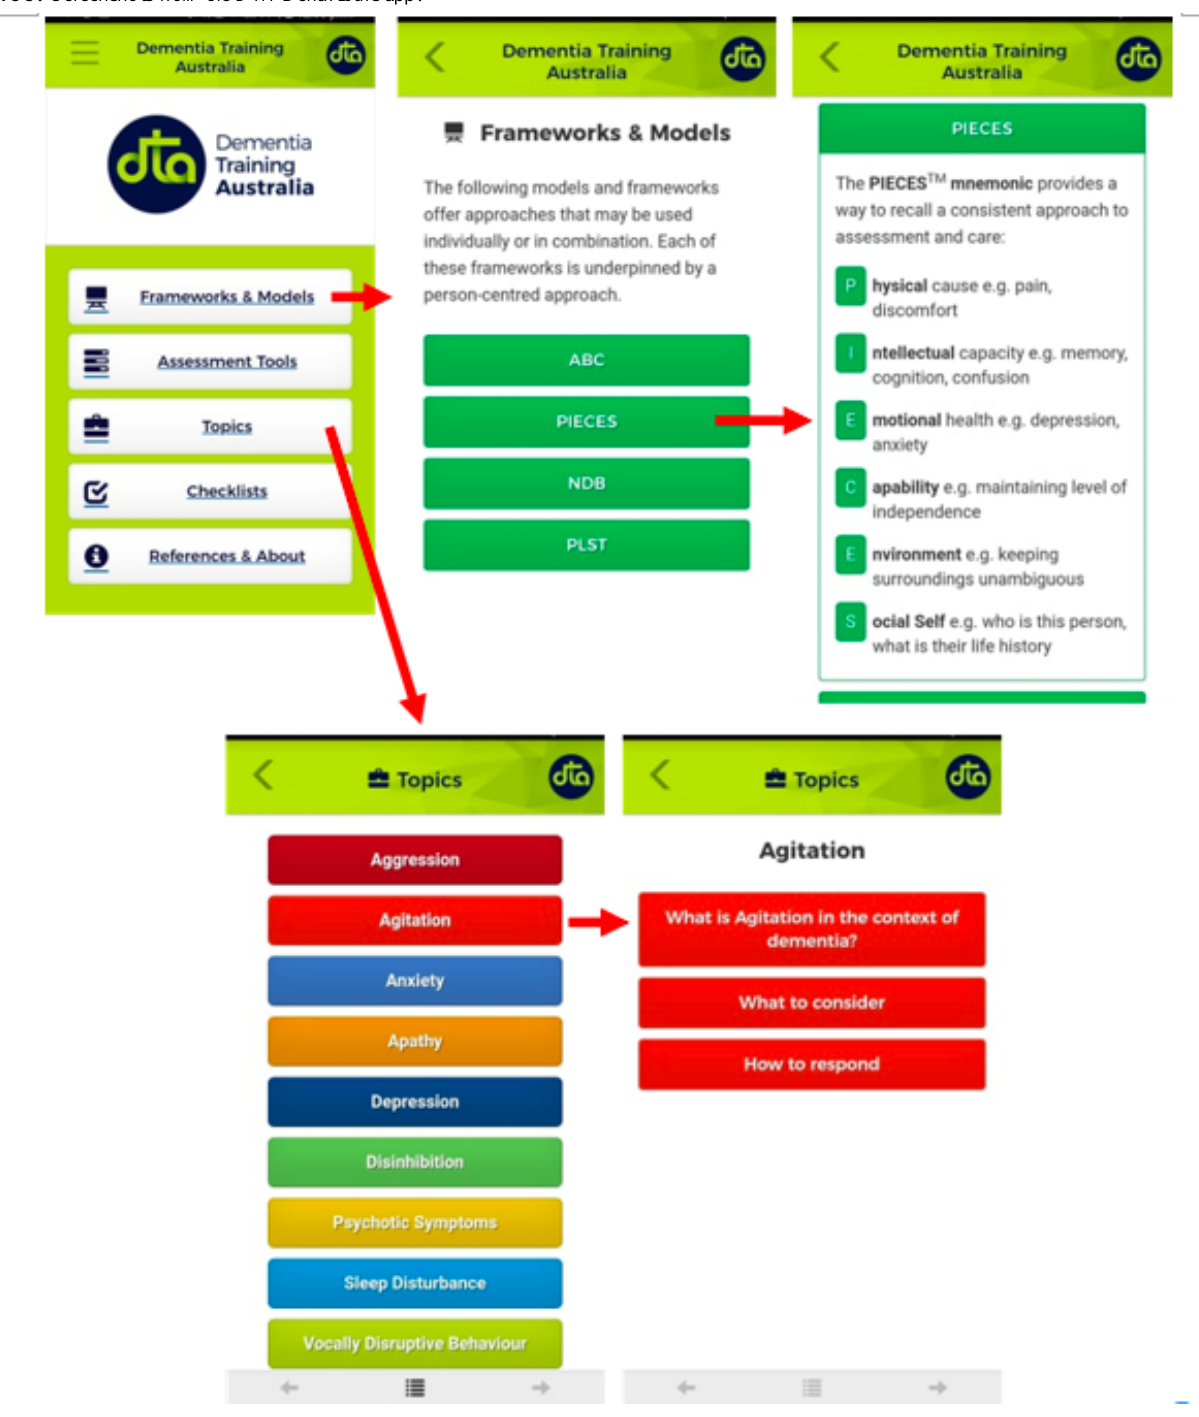
Figure 3. Screenshots from the DTA Behaviours